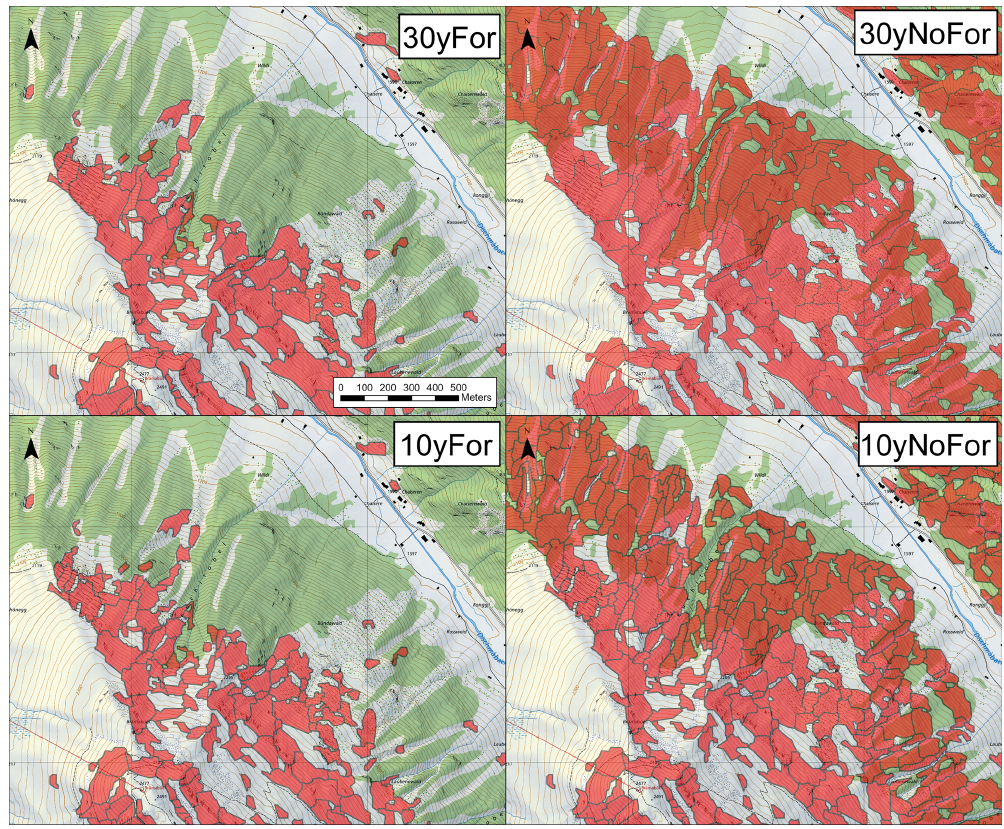
Figure 6. PRA delineation at the Duchli slope at the beginning of the Dischma valley close to Davos for the two frequent scenarios (30 and 10 years) with (For) and without (NoFor) taking the protective effects of the forest into account (map source: Swiss Federal Office of Topography).